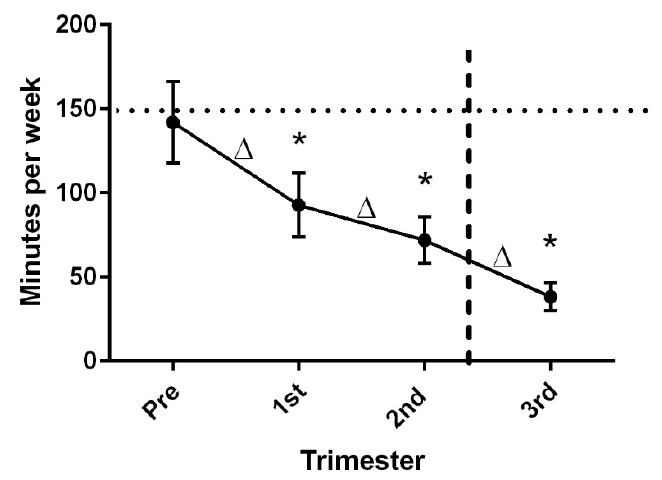
Figure 1. Physical activity levels in pregnancies complicated by FGR. Note: 1st, 2nd, and 3rd trimester timepoints on the graph represent the middle of each trimester. * p < 0.05, difference in PA level from recommended level (150 min/week); ∆ < 0.05, change in PA from one timepoint to the next; ···· denotes recommended amount of physical activity before and during pregnancy (150 min/week); - - - - denotes mean timepoint of FGR diagnosis (25.5 ± 5.9 weeks gestation). Table 3. Relationships between birthweight, estimated fetal weight, and physical activity levels during by